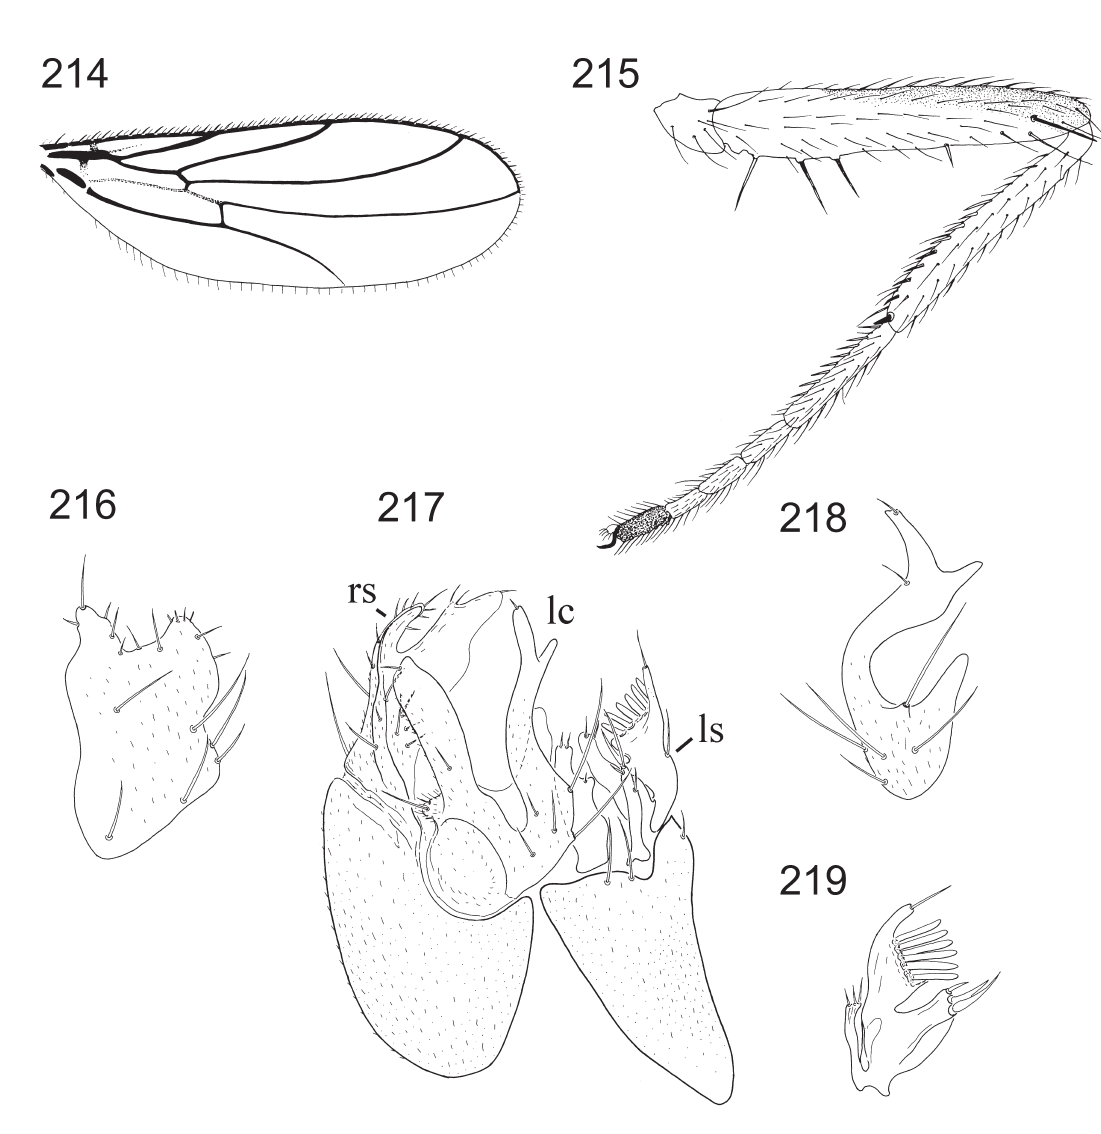
Figs 214-219. Stilpon malayensis Shamshev & Grootaert, 2004, ♂. 214 . wing, dorsal view. 215 . mid leg, anterior view. 216 . right surstylus, dorsal view. 217 . epandrium with cerci, dorsal view. 218 . left cercus, lateral view. 219 . left surstylus, lateral view. (after Shamshev & Grootaert